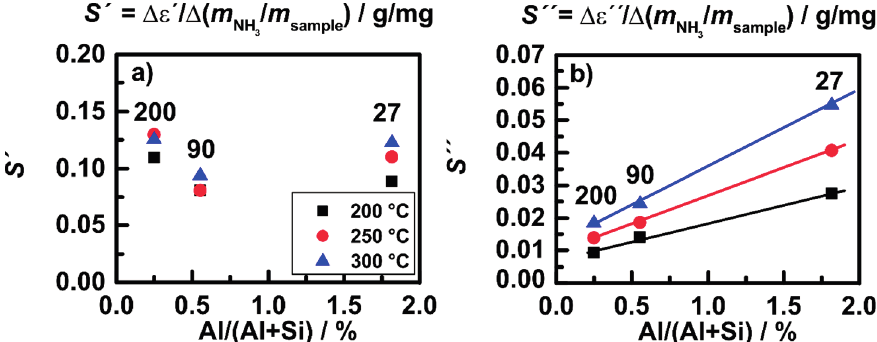
Figure 17. H-ZSM-5 powders: sensitivity of ( a ) ε ′ ; and ( b ) ε " over Al content of the different samples at 200, 250 and 300 °C. Adapted from